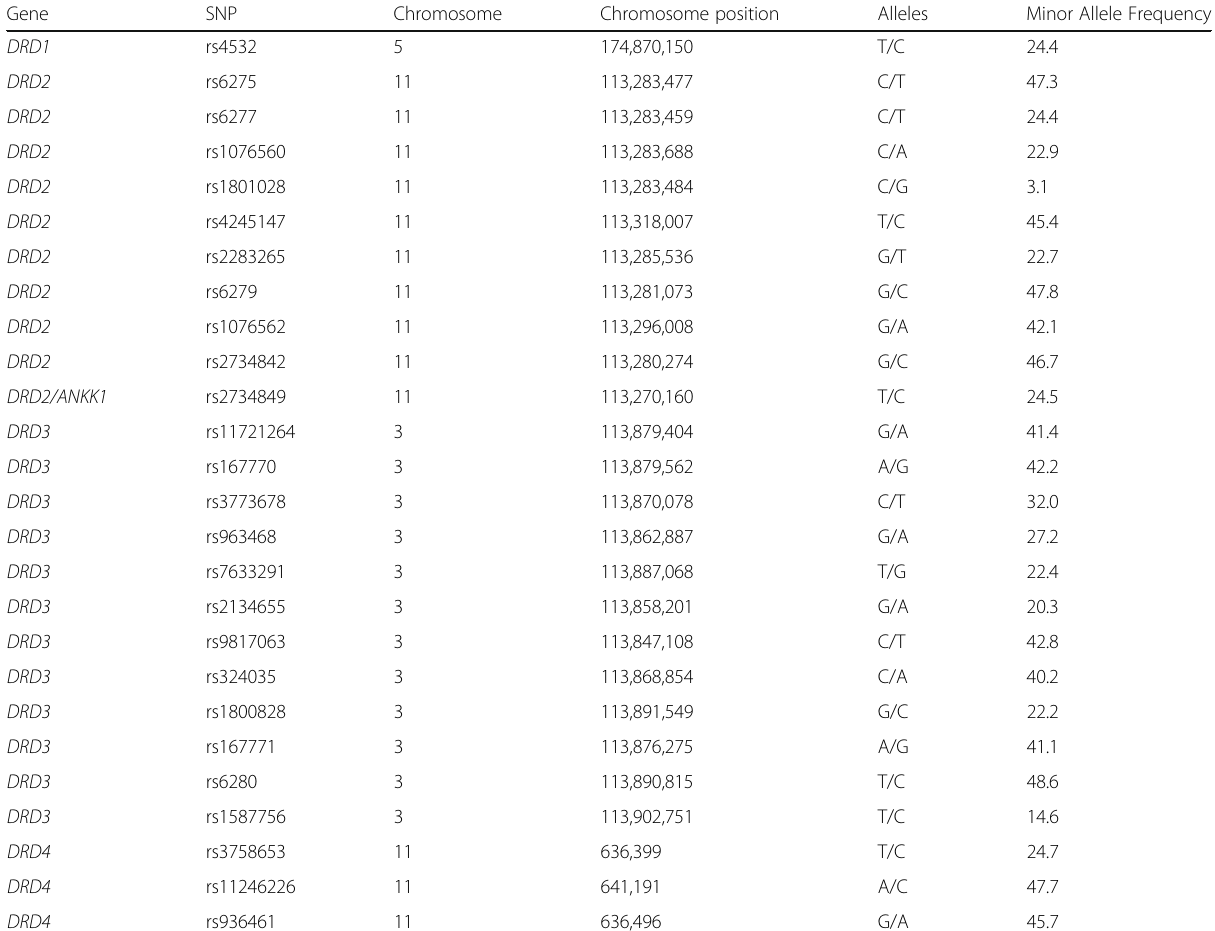
Table 2 List of analyzed polymorphic variants of dopamine receptor genes Gene SNP